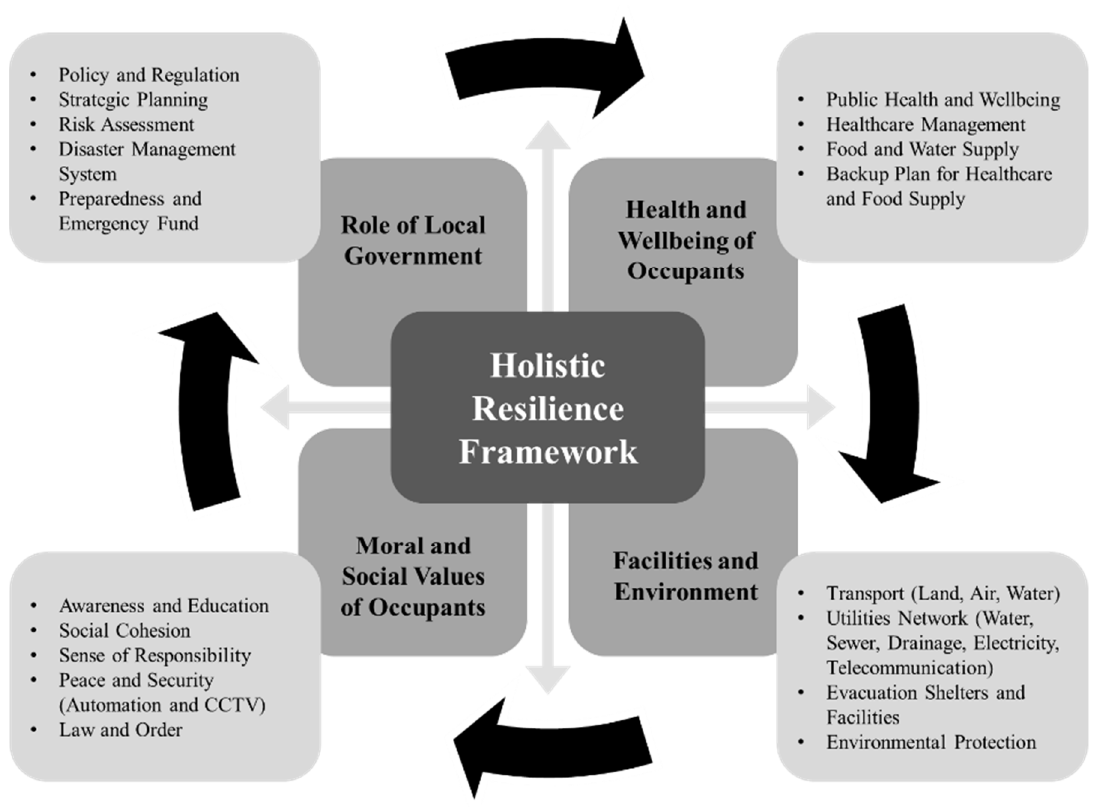
Figure 7. The proposed holistic resilience framework for buildings and critical infrastructure net ‐